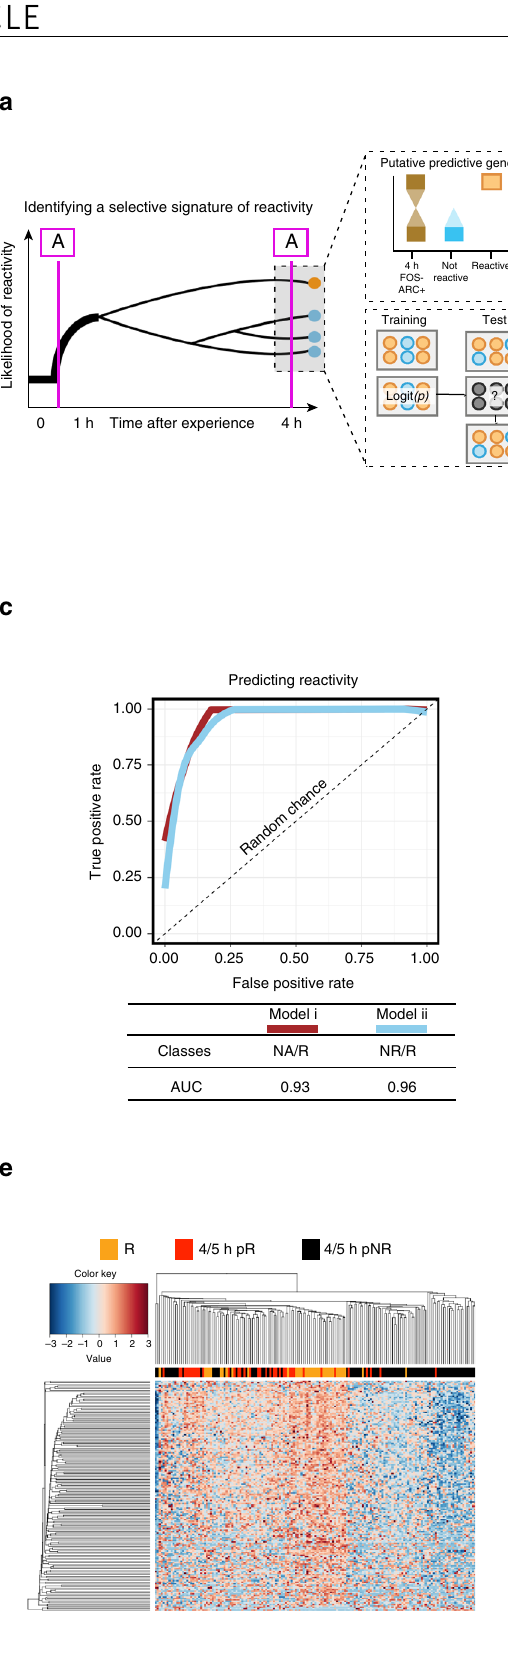
the top principal component (reactivity component) that 1.77e − 09; A > A second p < 9.22e − 09) based on the full tran- separated either (i) FOS + nuclei into late and early signature scriptome (Supplementary Fig. 6f). The models that were trained clusters (Supplementary Fig. 6e) (Student ’ s t -test: A > A original p on the original cohort were then used to calculate the probability of reactivity in the second cohort. Using the original A > A cohort < 5.20e − 16; A > A second p < 3.44e − 11) or (ii) late signature nuclei into FOS + and FOS − clusters (Student ’ s t -test: A > A original p < as a test case, the correlation between the reactivity component NATURE COMMUNICATIONS| (2018) 9:3084 |DOI: